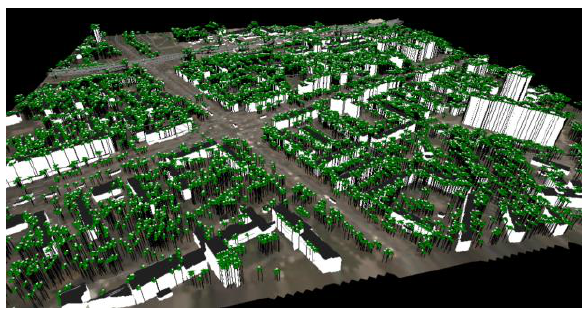
Figure 5. 3d visualization in Global mapper